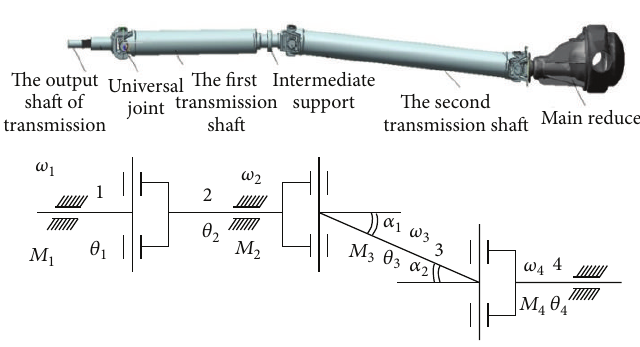
Figure 1: Universal transmission device structure investigated.